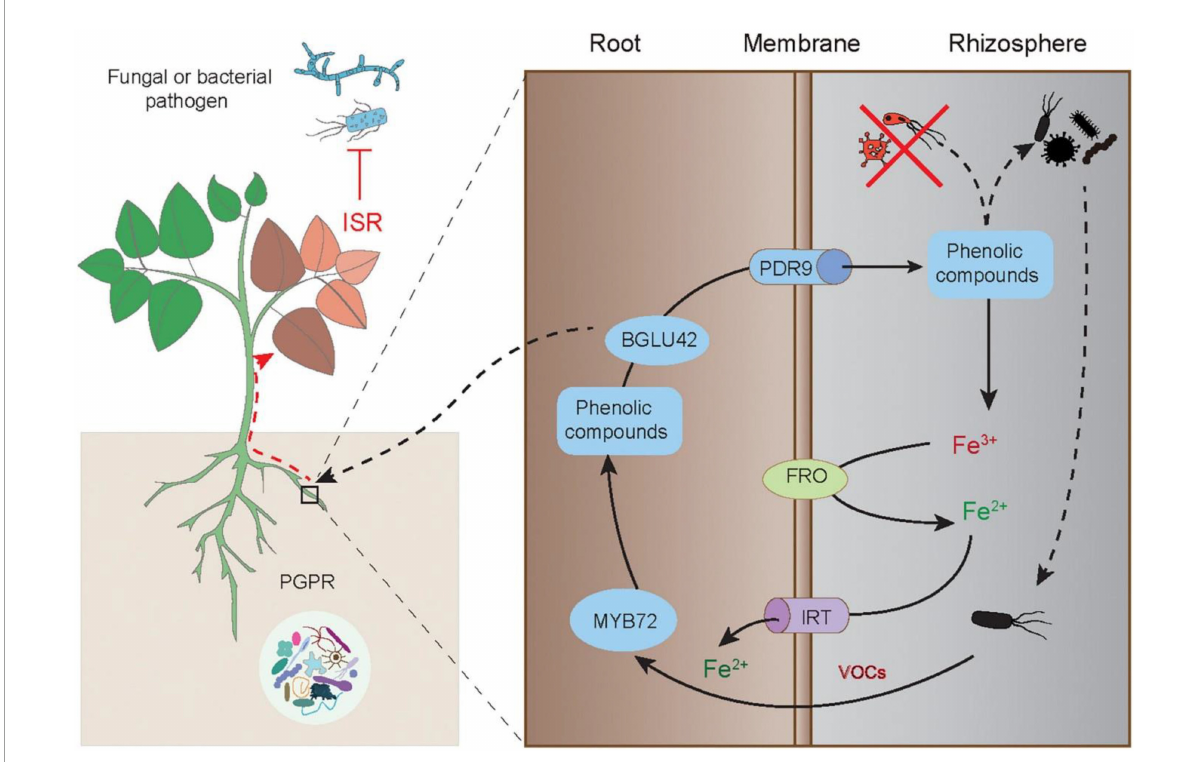
FIGURE3 Elicitation of the MYB72-mediated ISR in plants by PGPR-released VOCs. The root-specific gene MYB72 initiates the ISR and Fe uptake in plants induced by PGPR. The ISR-eliciting PGPR can activate the expression of MYB72, which controls the biosynthesis of fluorescent phenolic compounds, and the expression of BGLU42 encoding the glucose hydrolase gene and PDR9 encoding the ABC transporter gene, thereby triggering root exudation of phenolics. The root-released phenolics further promote the mobilization of Fe 3 + and make it available for reduction and uptake by plant roots. The phenolics can also shape specific rhizosphere microbiota. Moreover, the MYB72-dependent BGLU42 activity is essential for stimulating the ISR responses. This figure is acknowledged by Verbon et al.